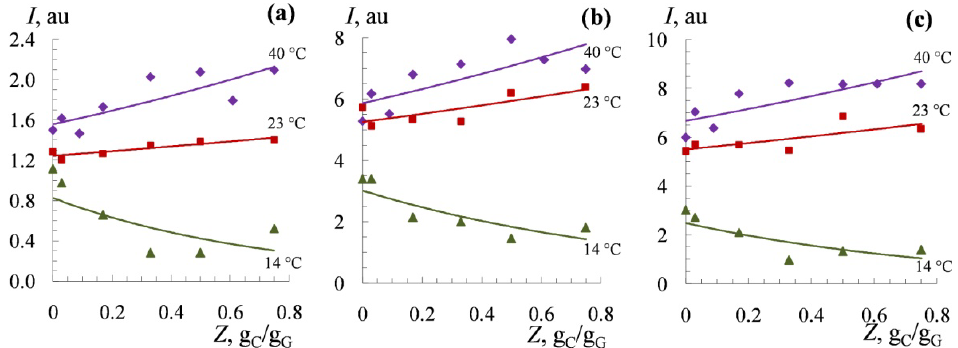
Figure 4. Integral signal intensity I for the protons of gelatin groups of Lys ε ‐CH 2 ( a ); Val , Leu , and Ile γ ‐CH 3 ( b ); and Hyp β ‐CH 2 ( c ) at the κ ‐carrageenan/gelatin w / w ratio Z , g C /g G , at different temperatures. Solvent: 99.8% D 2 O; I represented in arbitrary units relative to the signal at 7.39 ppm at 40 °C. Original figure.